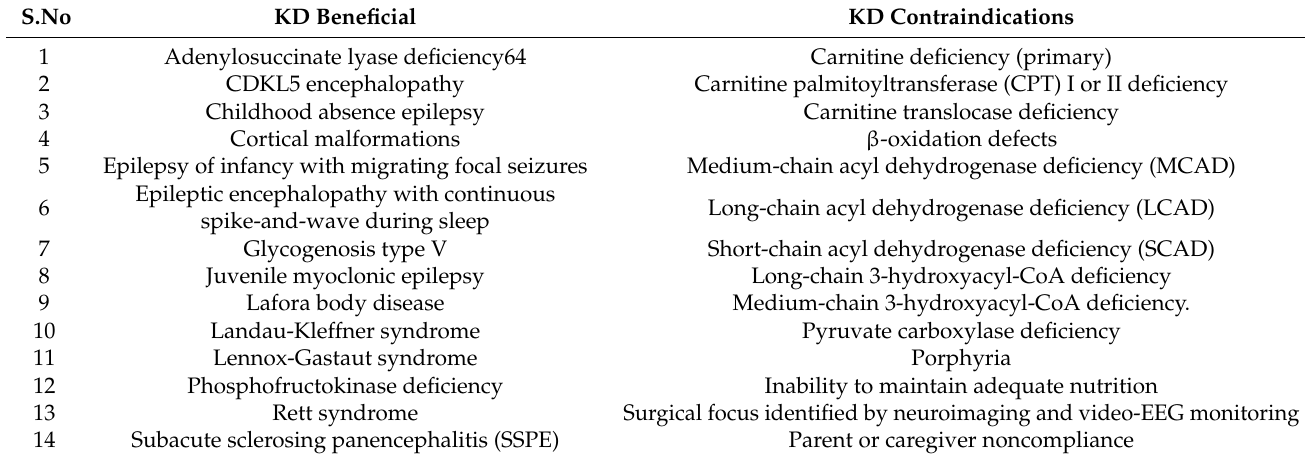
Table 2. Effectiveness KD in Epilepsy